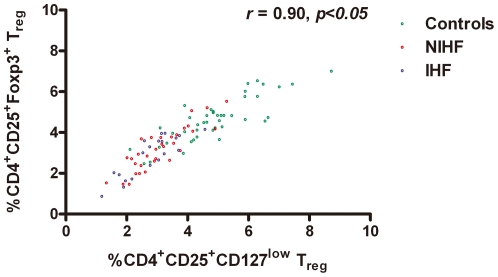
Correlation between CD4+CD25+ Foxp3+ Treg cells and CD4+CD25+CD127lowTreg cells.Frequencies of CD4+CD25+Foxp3+ Treg cells were plotted against CD4+CD25+CD127lowTreg cells in 47 CHF patients and 38 non-CHF controls (r = 0.91, p<0.001).